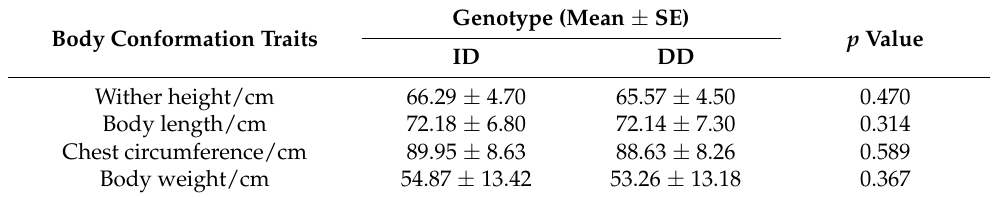
Table 3. Association analysis of LRRC8B gene polymorphism and body conformation traits in Chaka sheep. Body Conformation Traits